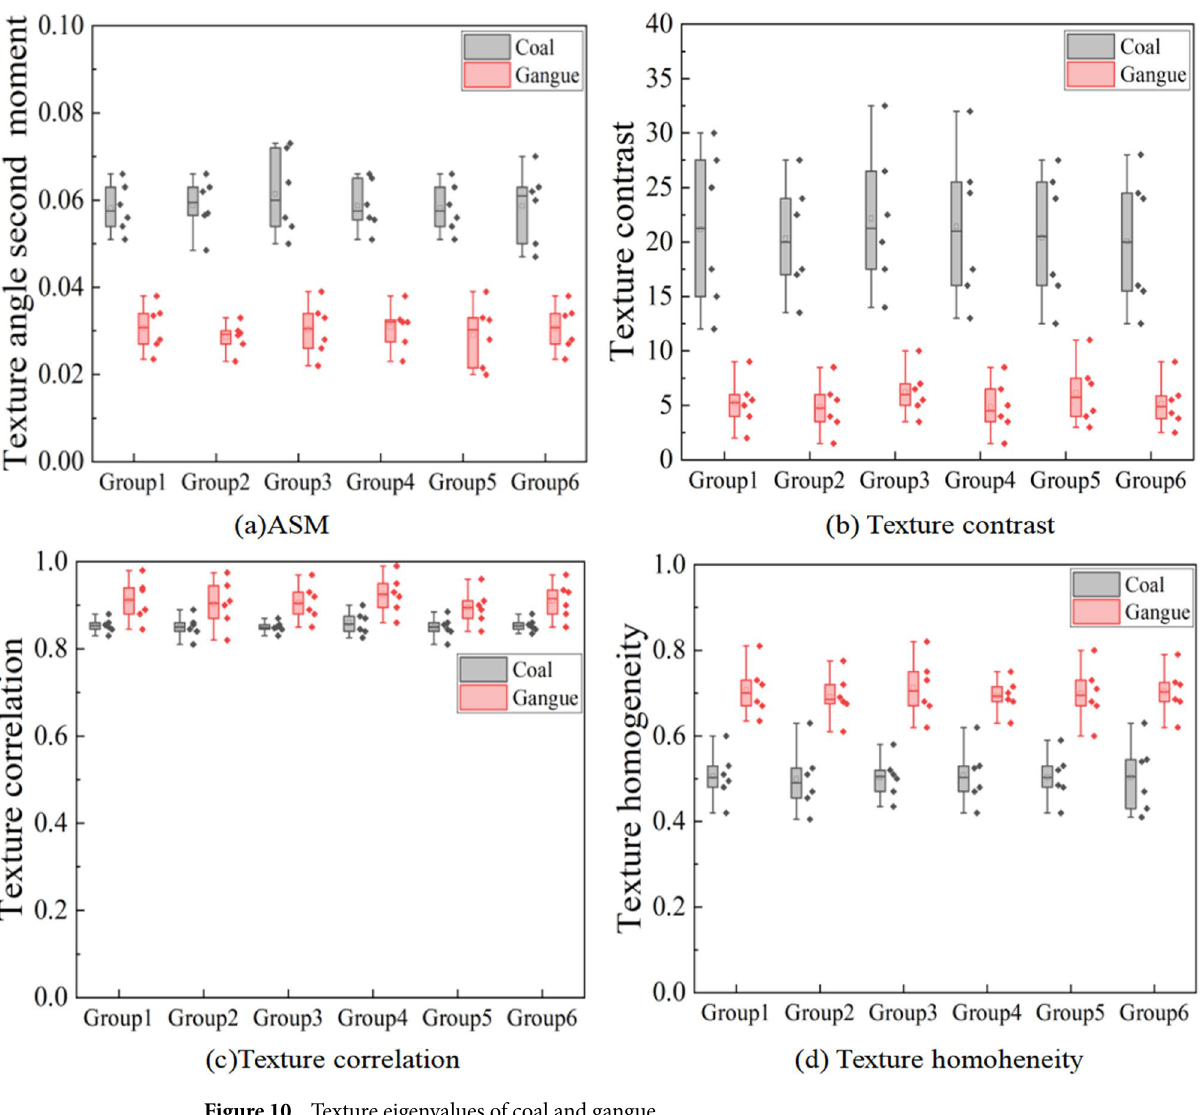
Figure 10. Texture eigenvalues of coal and